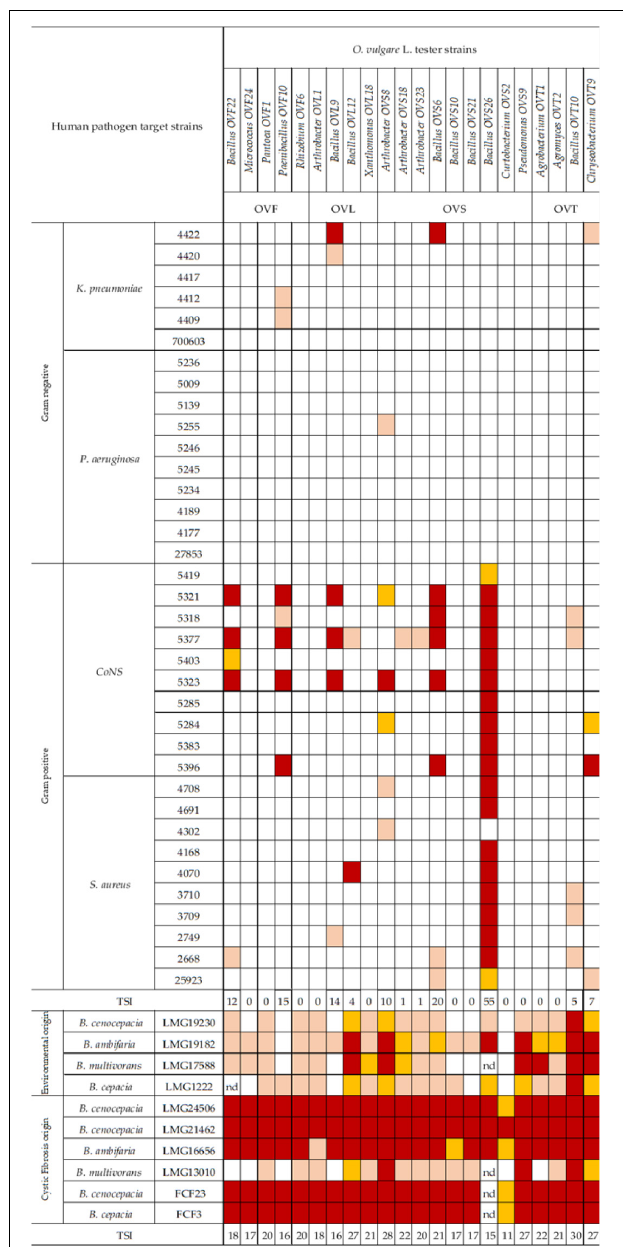
FIGURE 6 | Antagonistic interactions of O. vulgare associated strains against human pathogenic strains. The inhibition values reflect three different inhibition levels observed during the cross-streak experiments, that is, complete (3, red), strong (2, orange), weak (1, salmon), and absence (0, white) of inhibition. Nd (not detected) refers to results that were not obtained. TSI refers to the total score of